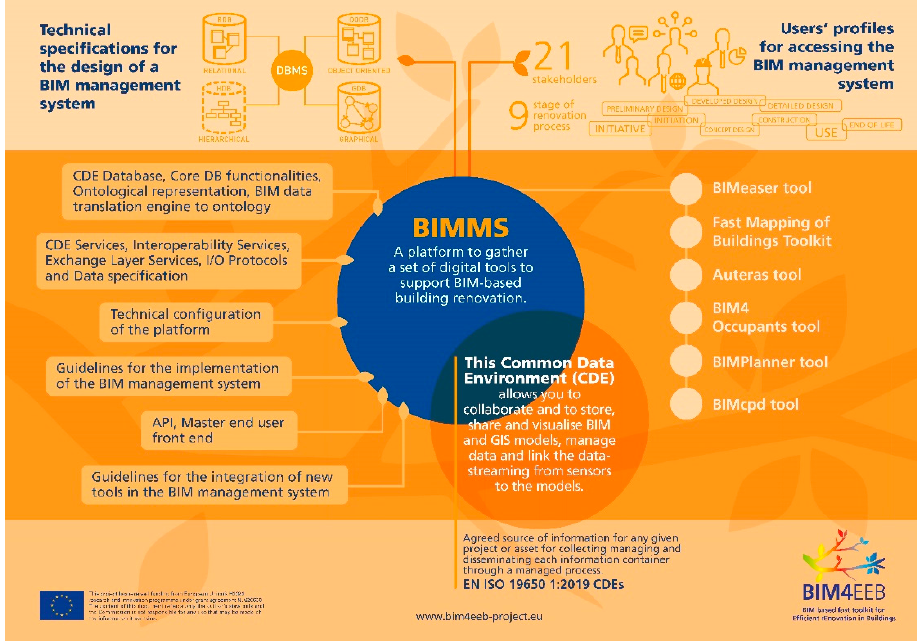
Figure 1. BIMMS general explanation and its relationship with other